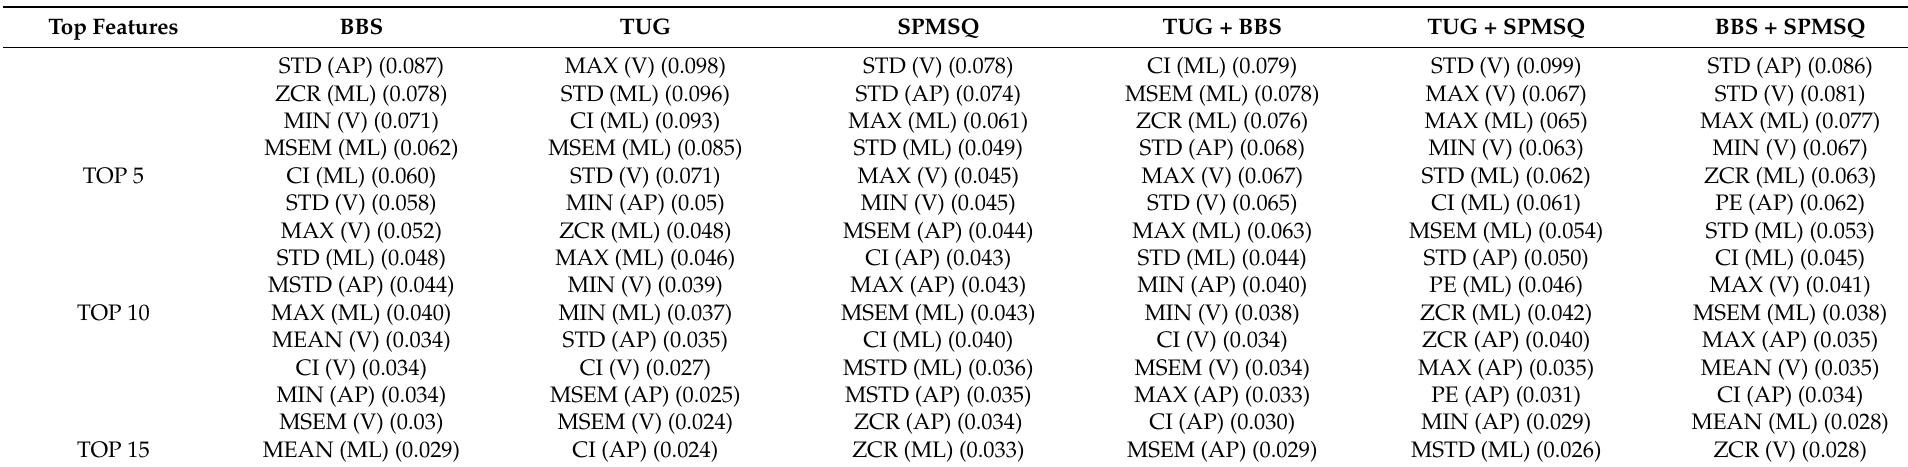
Table 4. Feature importance selection results, with the average feature importance coefficient in